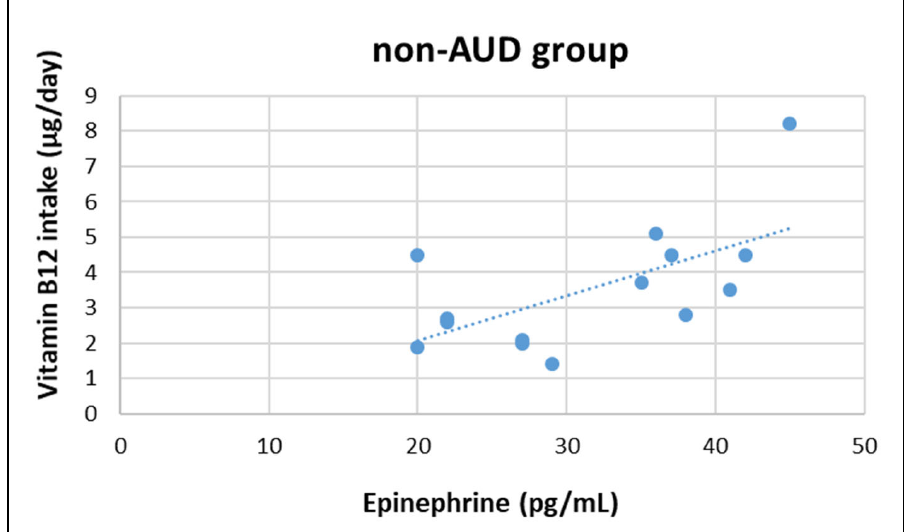
Figure 3. Correlation between plasma epinephrine concentrations and daily vitamin B12 intake in non ‐ AUD group.